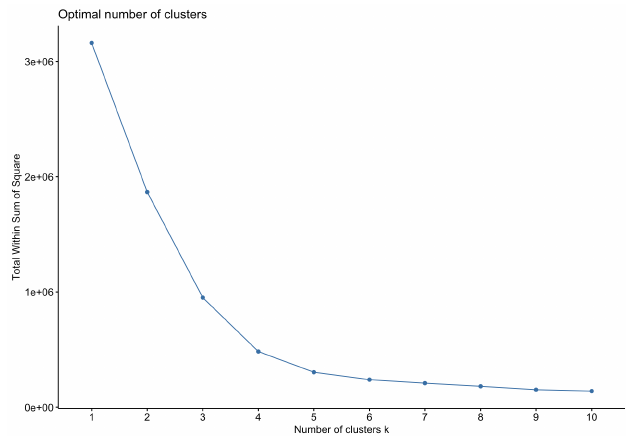
Figure 2: Within sum of squares to access optimal clustering